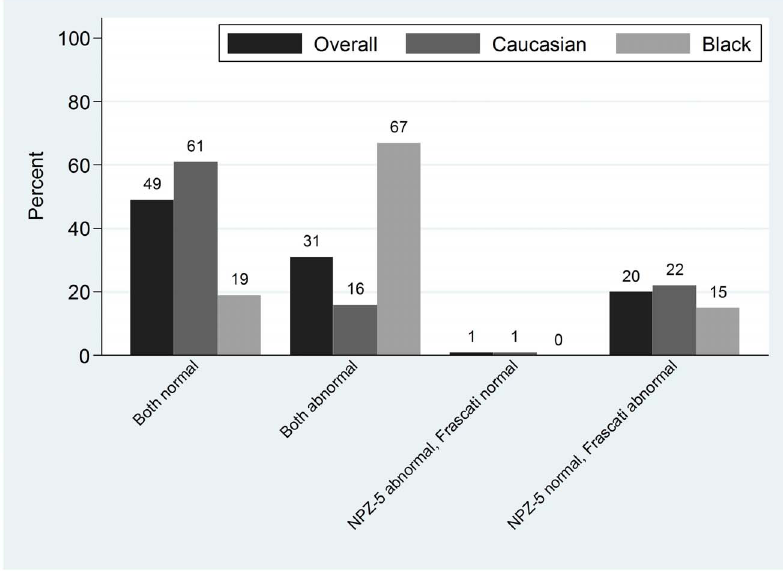
Figure 1. Association between NPZ-5 score and Frascati score.